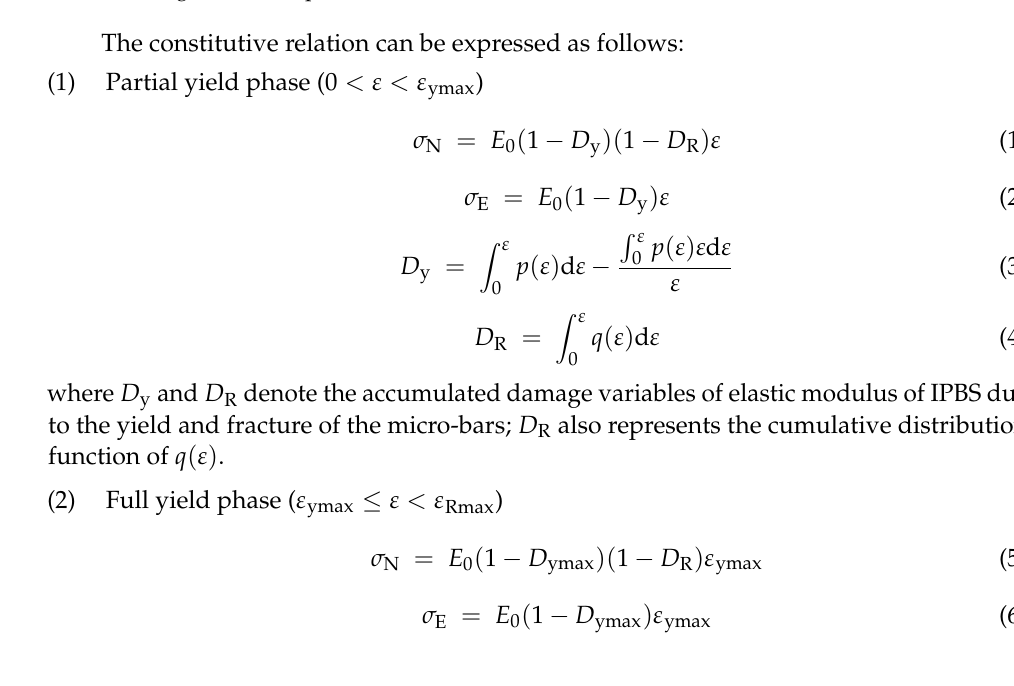
Figure 2. Mechanical behavior of concrete under uniaxial tension described by the Improved Parallel Bar System (IPBS): ( a ) micro bar and failure mode; ( b ) damage evolution process on meso-scale; ( c ) stress–strain curves on